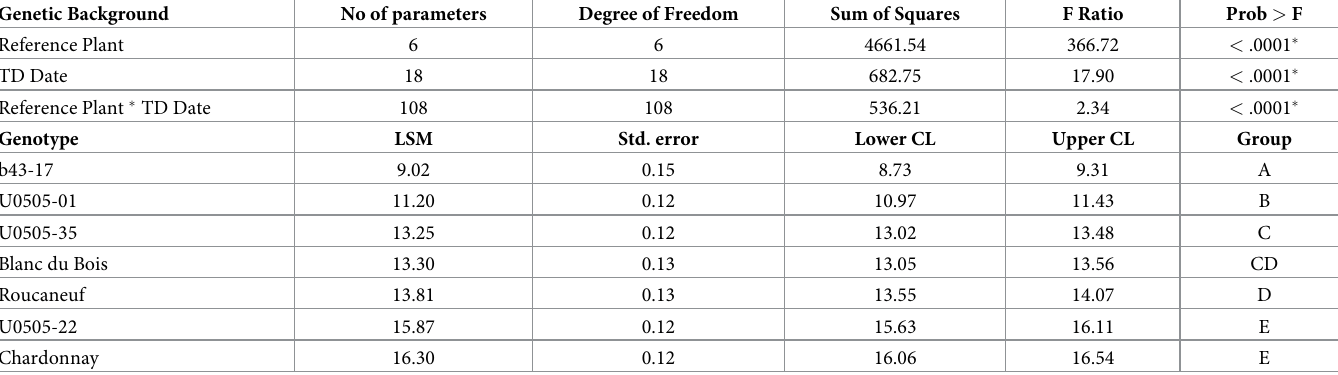
values, CMI, and LS/LL results on the maps, five categories and a similar color scheme was used (Fig 1 and S3 Fig). The categories to display ELISA results were: 1 (6.9–9.1), 2 (9.2–11.1), 3 (11.2–13.1), 4 (13.2–15.1), and 5 (15.2 and above). The five categories for the CMI and LS/LL scores were: 1 (0–1), 2 (1.1–2.0), 3 (2.1–3.0), 4 (3.1–4), and 5 (4.1and above). In all three cases, category 1 and 2 defined resistant accessions, category 3 and 4 possessed intermediate to bor- derline susceptible accessions, and the susceptible accessions were in category 5. S3 Table pres- ents the disease evaluation results in categories and accessions are organized from lower to higher values for ELISA, CMI, and LS/LL. Nineteen tested accessions were not included in the genetic analysis and therefore were not displayed on the maps in Fig 1 and S3 Fig. The correla- tion analysis indicates that overall ELISA results had a 75% and 68% correlation to CMI and LS/LL values, respectively, and CMI results had a 67% correlation with LS/LL. Fig 1 and S3 Fig present the ELISA, CMI and LS/LL categories for each tested accession, respectively. For all three the same color scheme was used for the five categories (dark green = 1, light green = 2, yellow = 3, orange = 4, and burgundy = 5). Results indicate that there is an east-west divide for PD resistance formed by the Sierra Madre Oriental and central Texas. Most accessions from eastern Mexico, the bordering state of Texas and the southeastern US had higher values for all three resistance parameters in comparison to accessions from the southwestern US and Mexico. These regions have contrasting climates. Eastern Mexico and southwestern US and northwestern Mexico, which have hotter and more arid conditions.